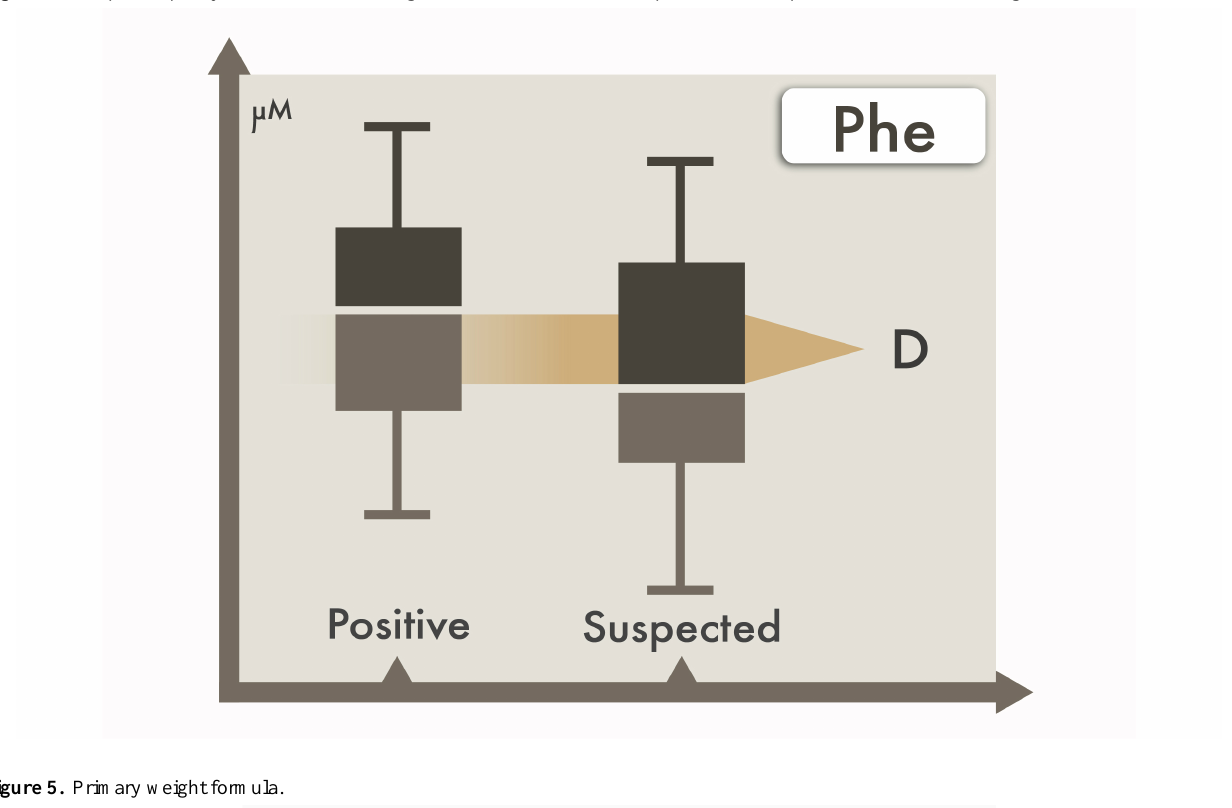
Figure 4. Boxplot of phenylalanine (Phe) showing the difference (D) between positive and suspected cases of the training data.